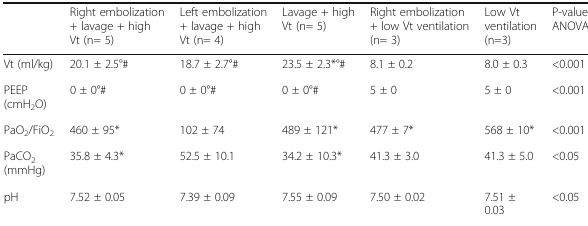
Table 15 (abstract A25). Ventilation pattern and gas exchange